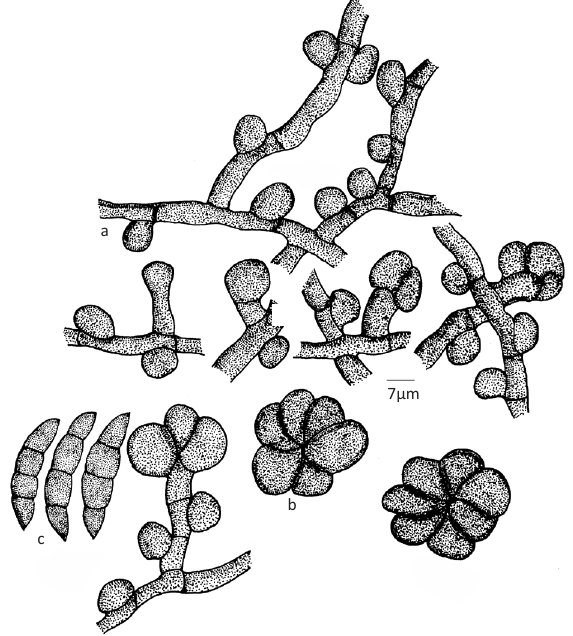
Figure 14. Sarcinella pogostemonis sp. nov. a - Appressoriate mycelium; b - Conidia of Sarcinella ; c - Conidia of Questieriella